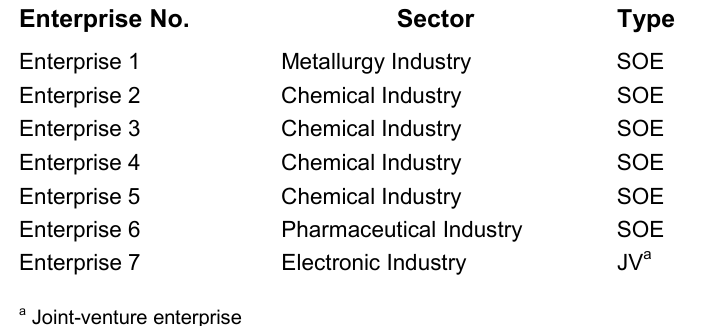
The Ownership and Sector of the Selected Enterprises Visited Enterprise No. Sector Type Enterprise 1 Metallurgy Industry SOE Enterprise 2 Chemical